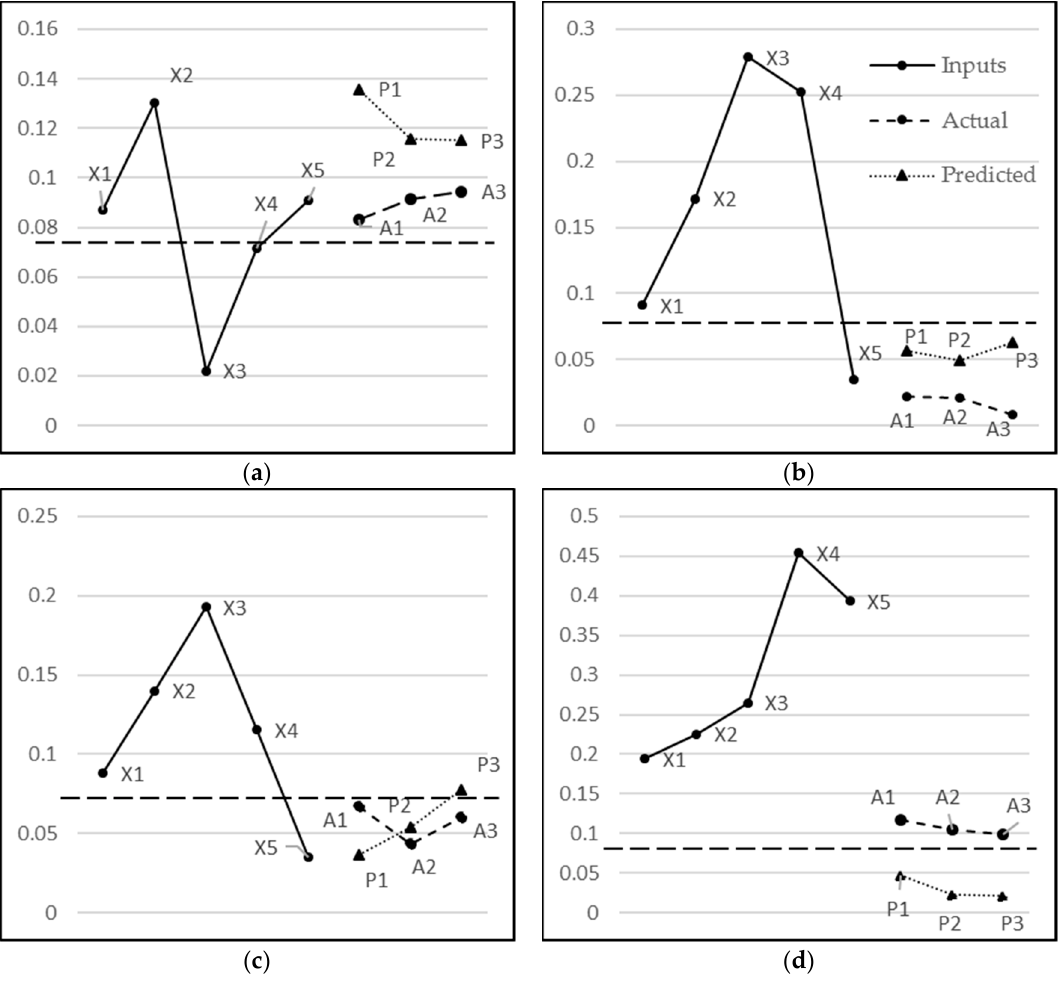
Figure 17. A representative case of each ( a ) TP (Actual & predicted decisions are ON); ( b ) TN (Actual & predicted decisions are OFF); ( c ) FP (Actual decision is OFF & predicted decision is ON); and ( d ) (Actual decision is ON & predicted decision is OFF) FN are shown where X1, X2, X3, X4, and X5 are the inputs; A1, A2, A3 are actual values; and P1, P2, P3 are the three-step-ahead predicted outputs. The dotted straight line at 0.075 is the T f for decision.